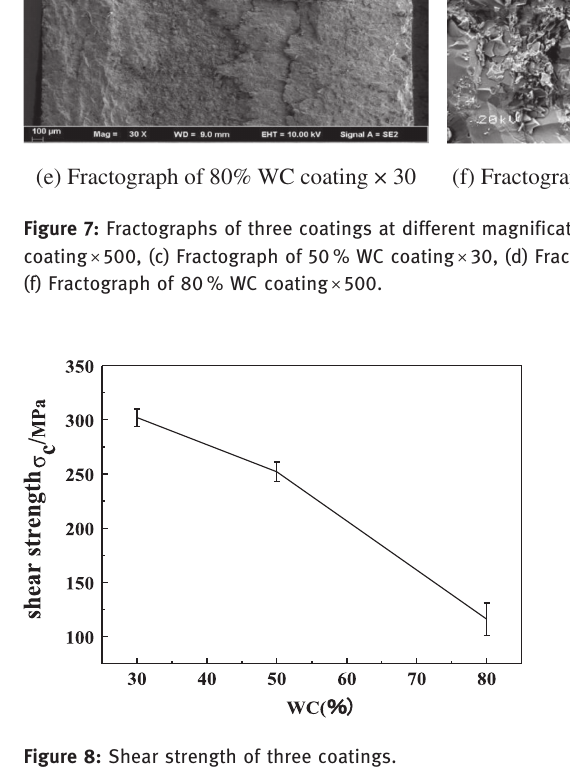
Figure 8: Shear strength of three coatings.